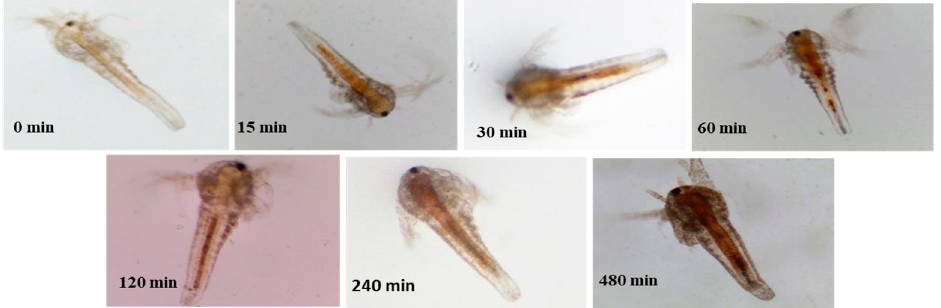
Figure 3. Microscopic observation of Artemia nauplii during bio-encapsulation and retention analysis.